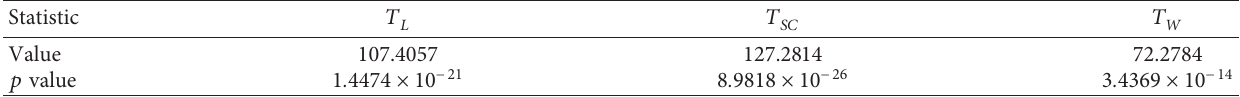
Table 16: Test statistics’ values and p